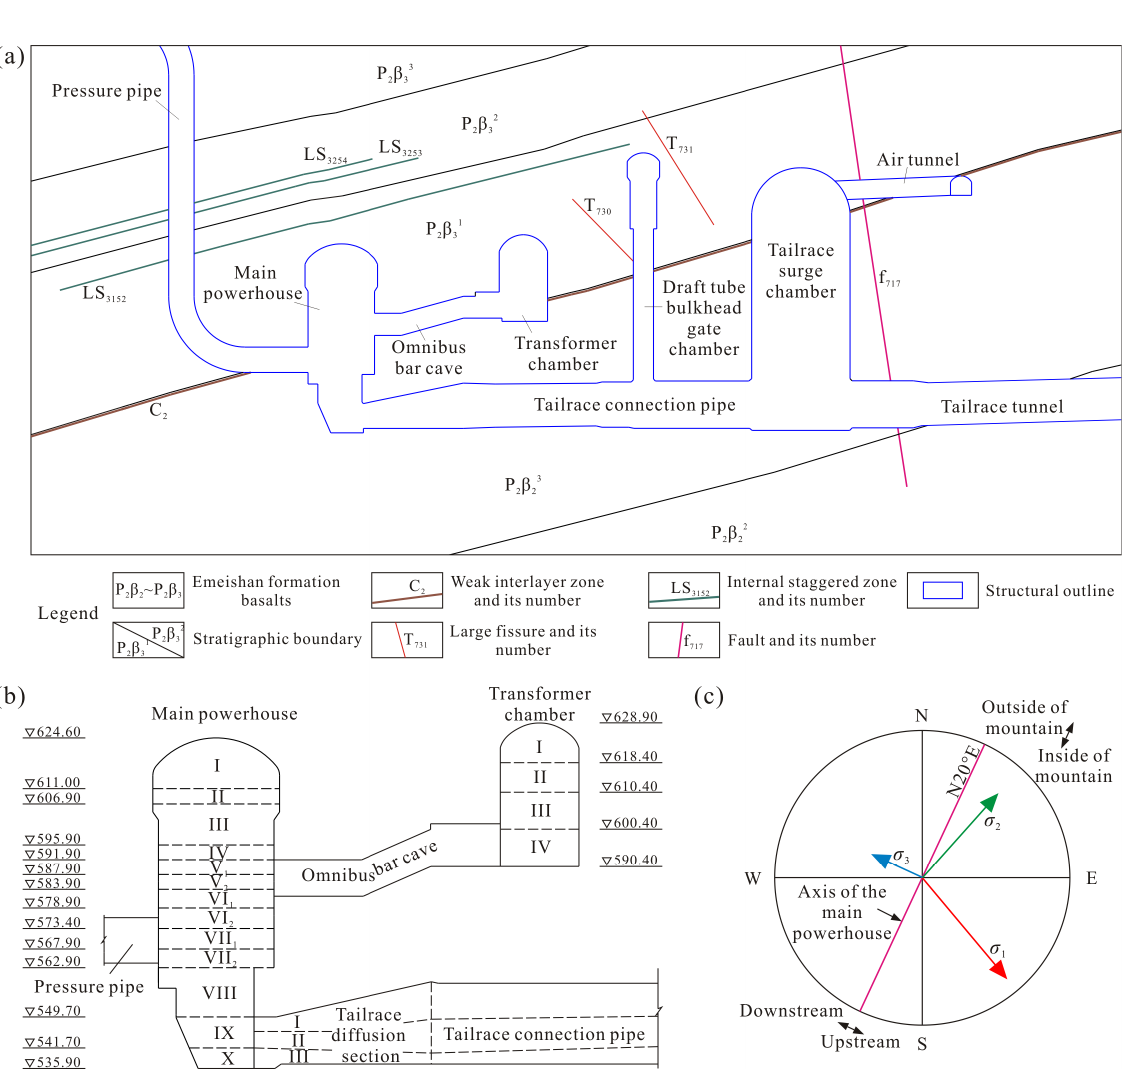
Figure 3. Geological conditions and excavation scheme of the left bank underground powerhouse: ( a ) a geological cross-section along unit #6, ( b ) the stratified excavation scheme and ( c ) the direction of the in situ stress.